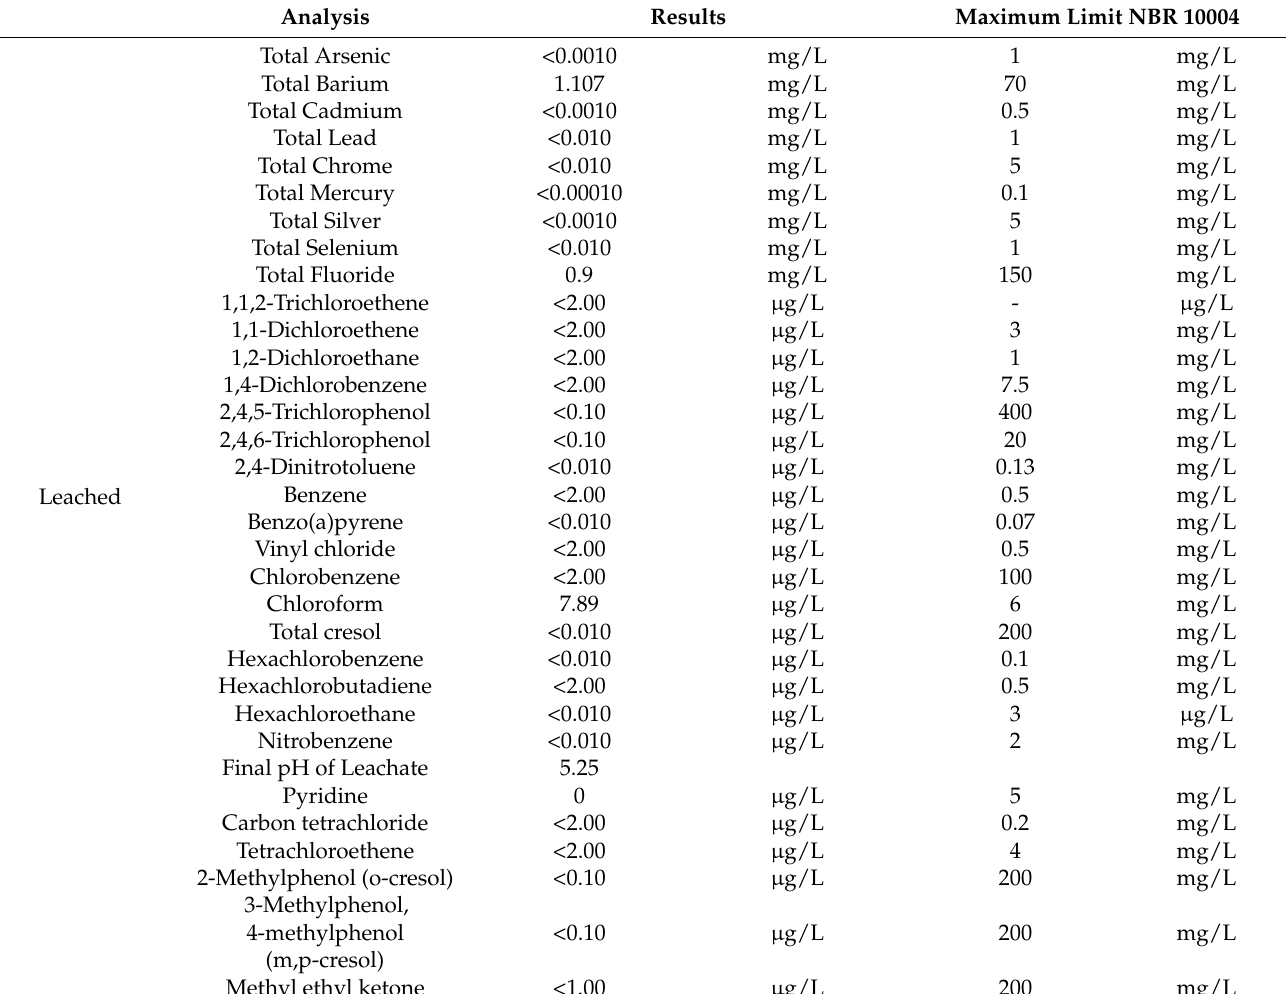
Table 4. Analytical results of the leach extract.